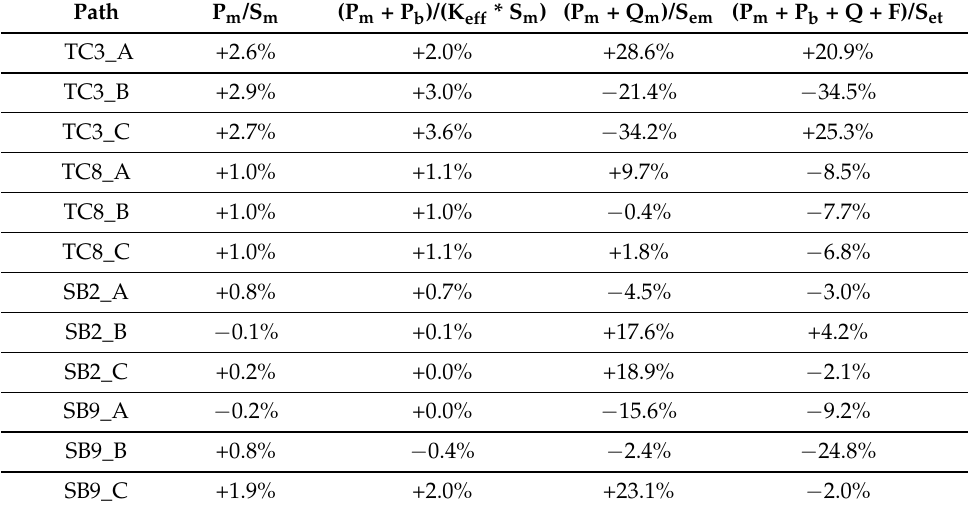
Table 4. Comparison of the RCC-MRx criteria verification